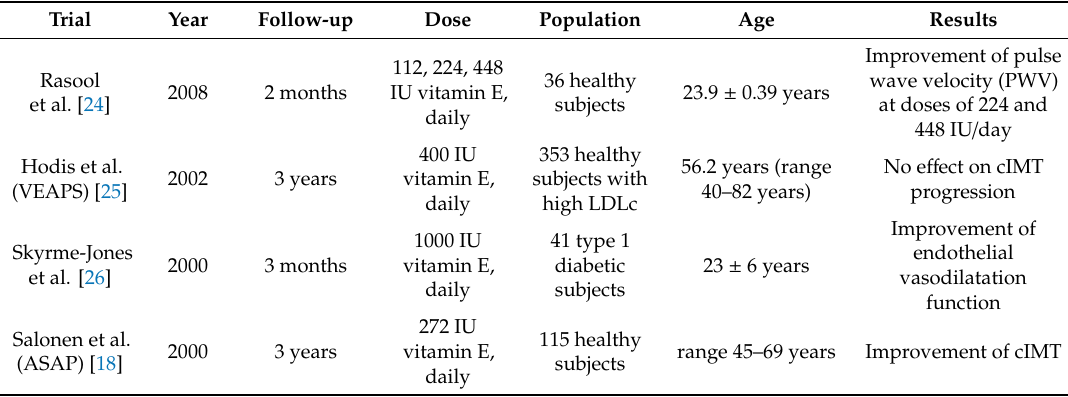
Table 1. E ff ects of vitamin E supplementation on subclinical atherosclerosis in patients without manifest